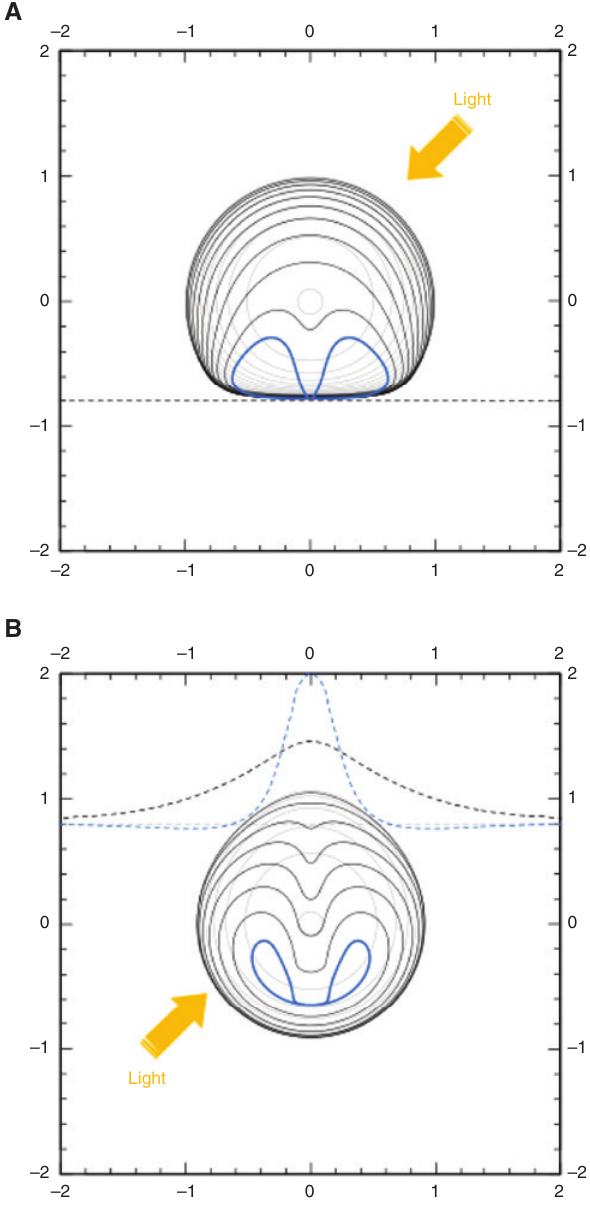
Figure 11: Simulations of gas bubble collapse. Simulation of an asymmetric cavitation bubble during its growth (thin grey curves), collapse (thick black curves) and jet impact (blue curves). (A) The bubble is located near a rigid surface (dashed line). (B) The bubble is located near a free surface (dashed curves). Note that the free surface is perturbed by the changes in the bubble’s shape and its eventual collapse. The coordinates are in the units of the maximum bubble radius [187]. The interaction of the incident light with the bubble and the adjacent surface provide access to giant nonlinearities. Simulations were carried out with a computational code developed by Danail Obreschkow, the University of Western Australia